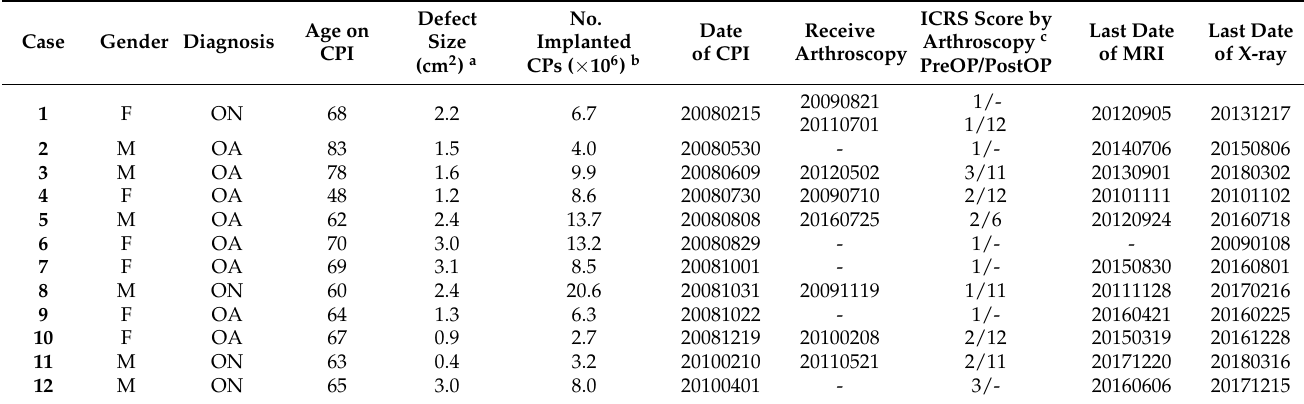
Table 1. Demography of the